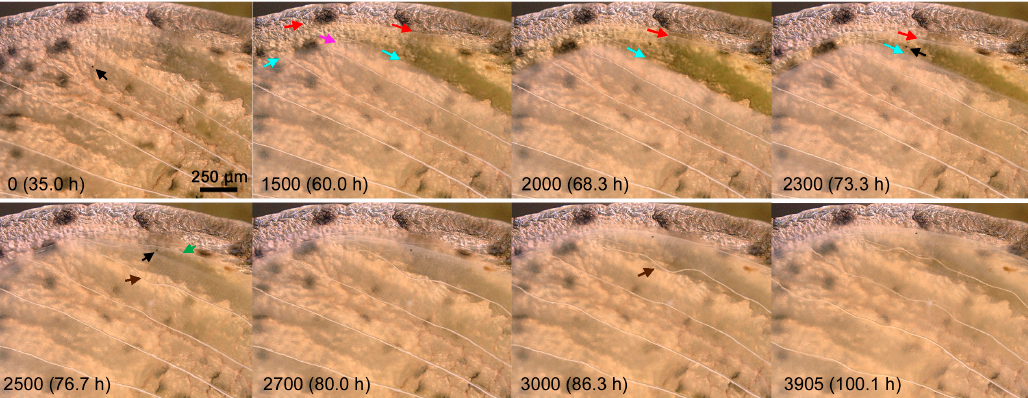
Figure 6. Dynamics of the pupal forewing along the hind (inner) margin (right) and outer margin (left). This is a different individual from that in Figures 3–5. The image number and postpupation time are indicated in each panel. The edges of the ventral forewing (blue arrows), edges of the dorsal forewing (red arrows), bent trachea (a pink arrow in IN1500), loosened tracheae (brown arrows in IN2500 and IN3000) and a representative hemocyte at the wing margin (a green arrow in IN2500) are indicated. Among hemocytes, a large black one, often seen also in the other two individuals, is indicated by black arrows in IN2300 and IN2500. See also Video S3.